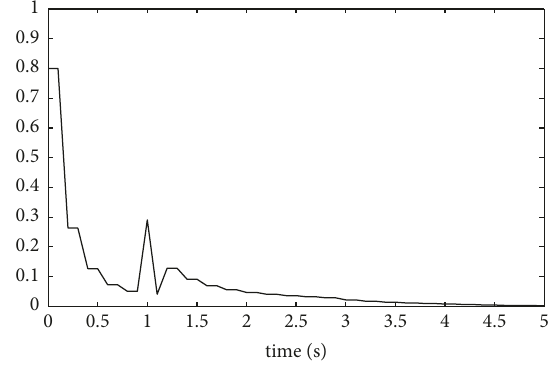
Figure 3: The evolution of 𝑥 𝑇 (𝑡)𝛼 of system